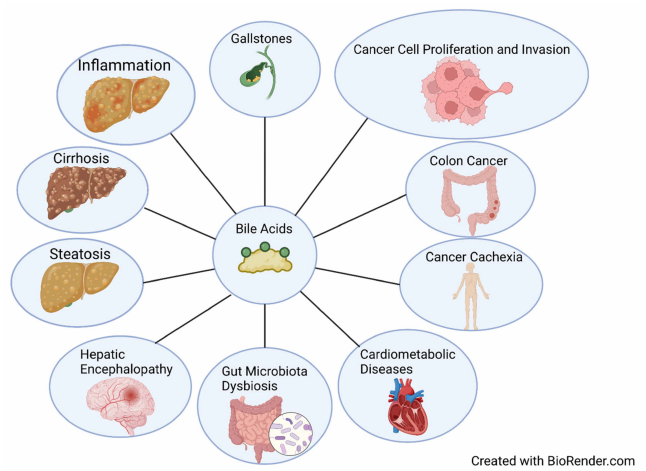
Figure 4. Bile acids in disease. Visual representation of the clinical significance of bile acids by showing their connection to different disease states and